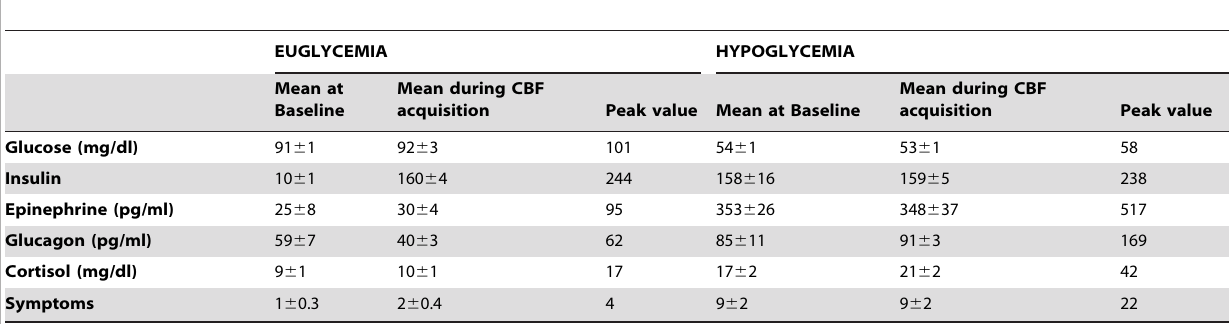
Table 1. Mean ( 6 SE) plasma glucose and counterregulatory hormones at baseline and at time of CBF acquisition for euglycemic and hypoglycemic clamp phases and peak levels during each phase.